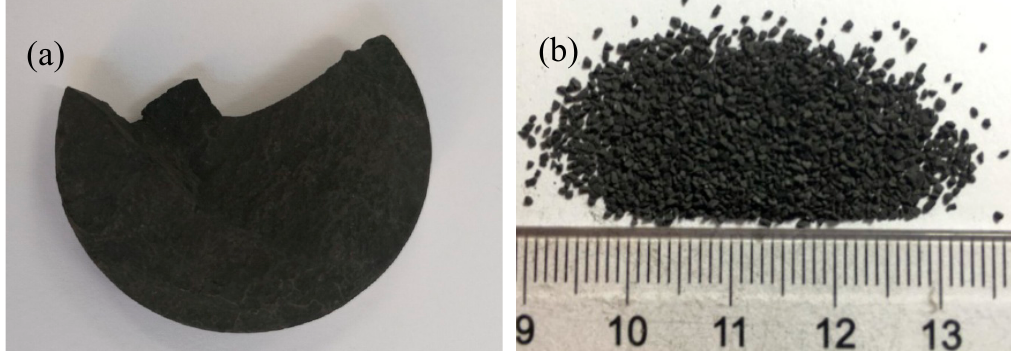
Figure 1. ( a ) raw shale sample; ( b ) crushed shale samples.